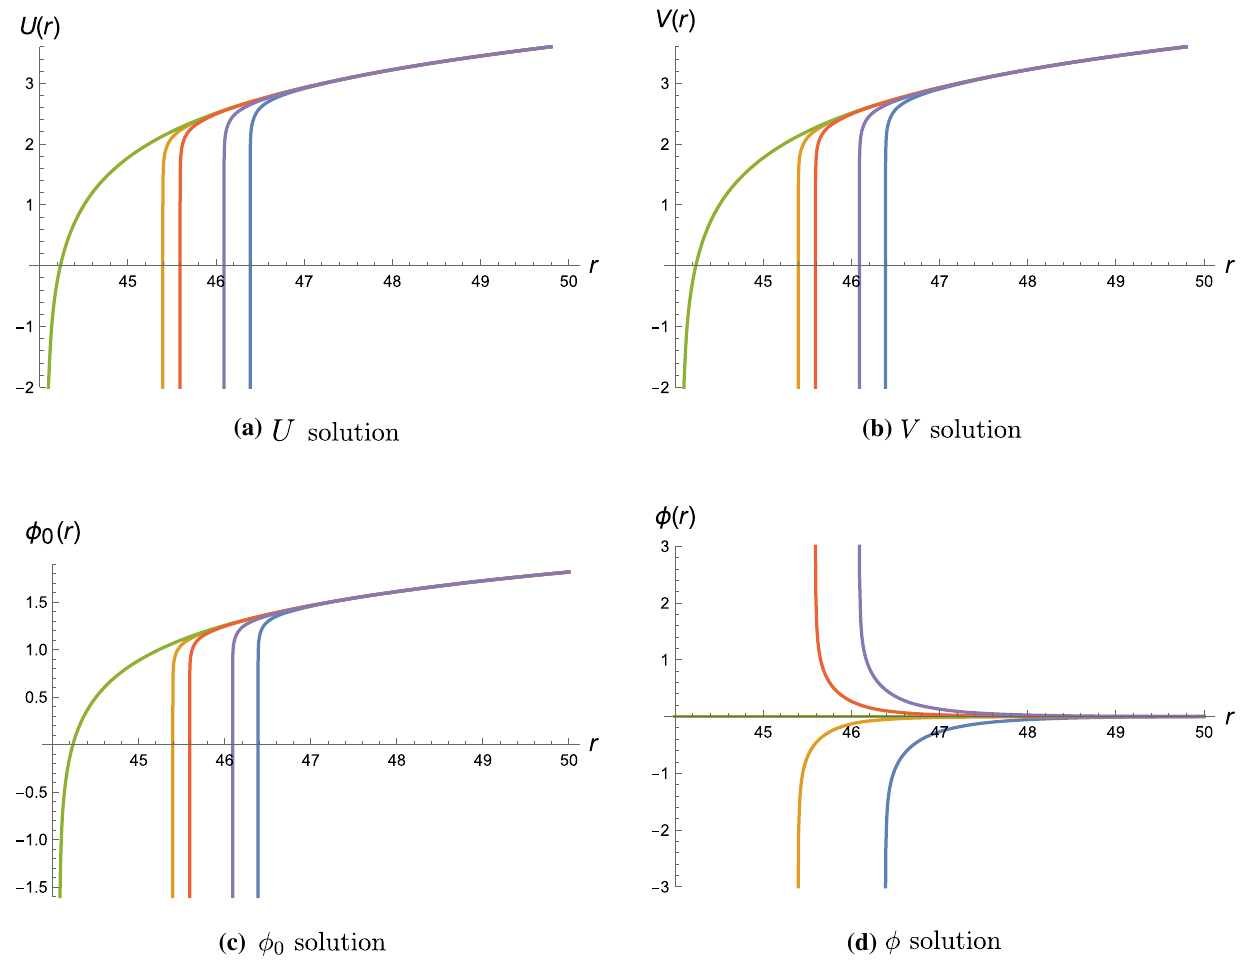
Fig. 32 Supersymmetric flows interpolating between asymptotically locally flat domain walls and Mk w 4 × R 2 -sliced domain walls for SO ( 2 ) × SO ( 2 ) twist in SO ( 4 ) gauge group. The blue, orange, green, red and purple curves refer to p 2 = − 0 . 5 , − 0 . 03 , 0 , 0 . 06 , 0 . 25, respectively with ρ = − 1 , 0 , 1 corresponding to SO ( 3 , 1 ) , CSO ( 3 , 0 , 1 ) and SO ( 4 ) gauge groups,